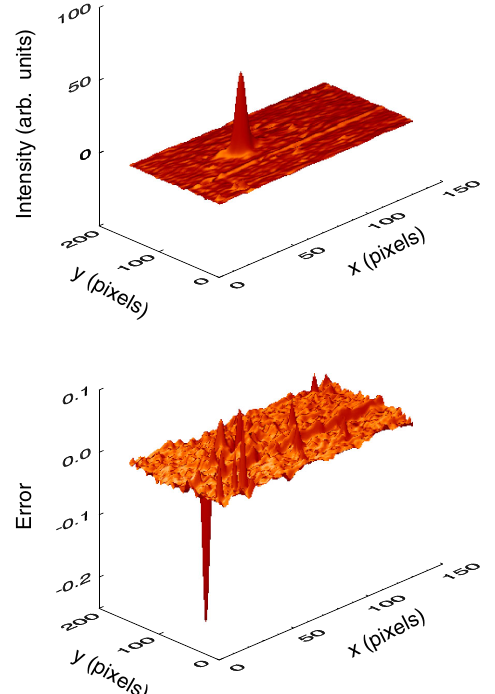
FIG. 15. Measured intensity data taken in 2003 and the residual using error ¼ð measureddata − fitdata Þ = max ½ abs ð measureddata Þ(cid:2) . The calibration is 0 . 9 μ m per pixel in the x directions and 1 . 057 μ m per pixel in the y direction. The error between measured and fitted data is less than